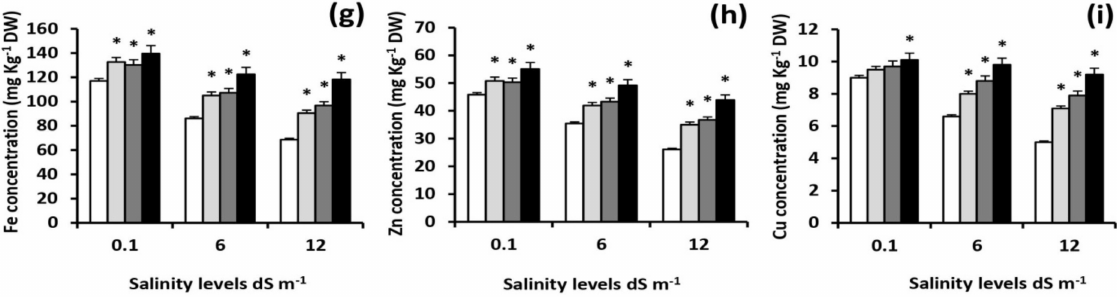
Figure 2. Influence of salicylic acid (SA, 75 mg L − 1 ), melatonin (MT, 70 µ M), and SA (75 mg L − 1 ) + MT (70 µ M) foliar application treatments on the concentrations of ( a ) nitrogen (N), ( b ) phosphorus (P), ( c ) potassium (K + ), ( d ) sodium (Na + ), ( e ) calcium (Ca 2+ ), ( f ) magnesium (Mg 2+ ), ( g ) iron (Fe), ( h ) zinc (Zn), and ( i ) copper (Cu) (mg g − 1 DW) in grains of wheat plants grown under 0.1, 6, and 12dS m − 1 salinity levels. Data are means of four replicates (n = 4) and bars show standard errors ( ± SE). Asterisk represent significant differences between treatments at the p < 0.05 level according to LSD test.